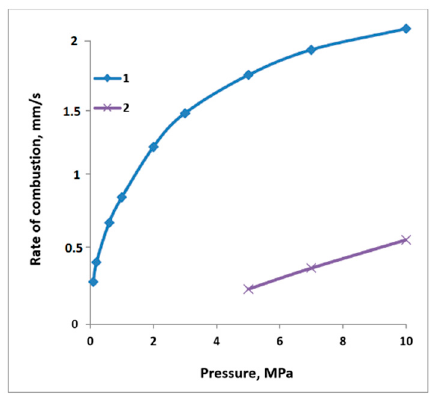
Figure 12. Impact of pressure on the rate of combustion of Cr under natural filtration conditions. 1—avg. ≈ 5 µm, 2—63–80 µm. Table 2. Parameters of the combustion of chromium under natural and forced filtration. Combustion Parameters Natural